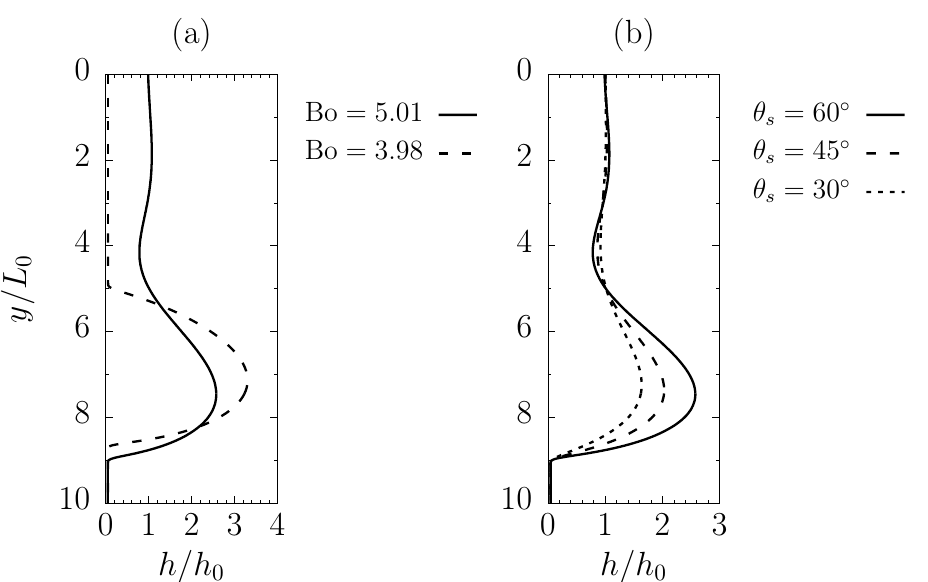
Figure 2. Stable film solution (continuous line) and self-similar droplet (dashed line) generated by film rupture at slightly different Bond numbers , θ s = 60 ◦ ( a ); Stable film solution at different surface wettabilities, Bo = 5.01 ( b ). α = 60 ◦